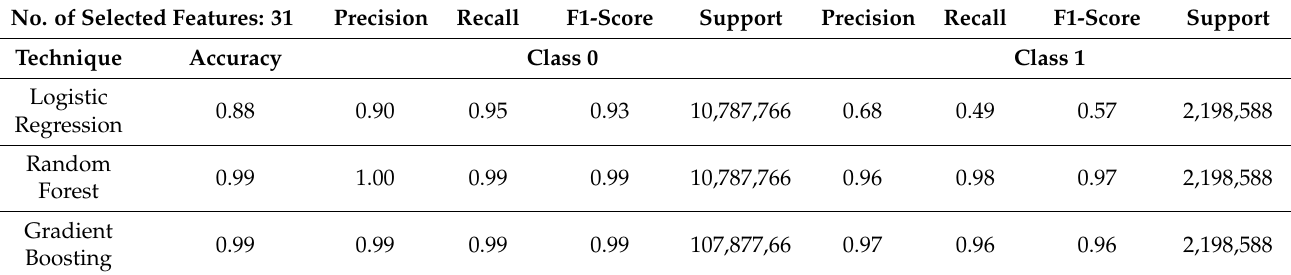
Table 1. Results for training dataset.